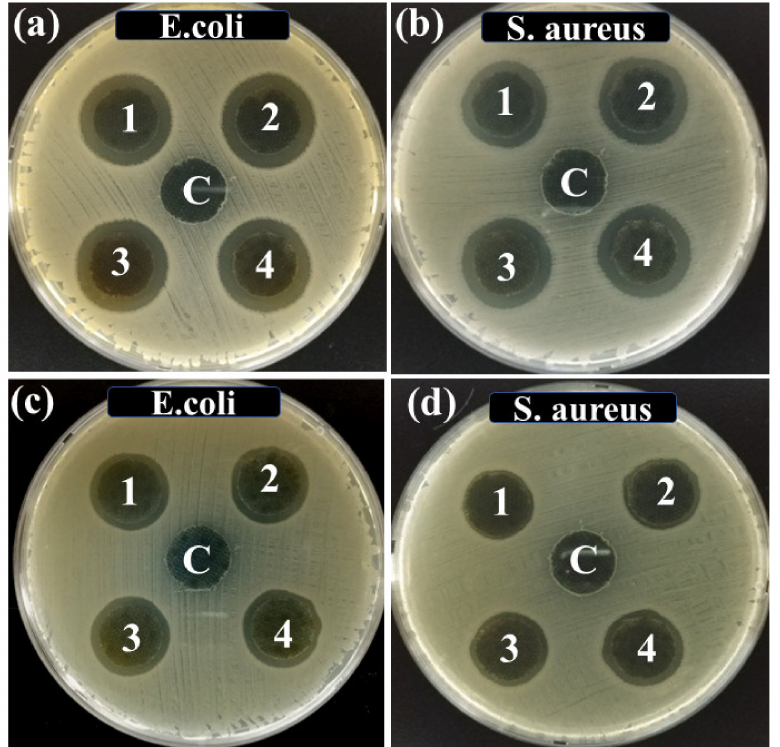
Figure 8. Zone of Inhibition (ZOI) of samples (C, 1, 2, 3, and 4) containing different concentrations of Ag NPs-PTA ( a , b ) and bare Ag NPs ( c , d ) measured against S. aureus and E. coli microbial